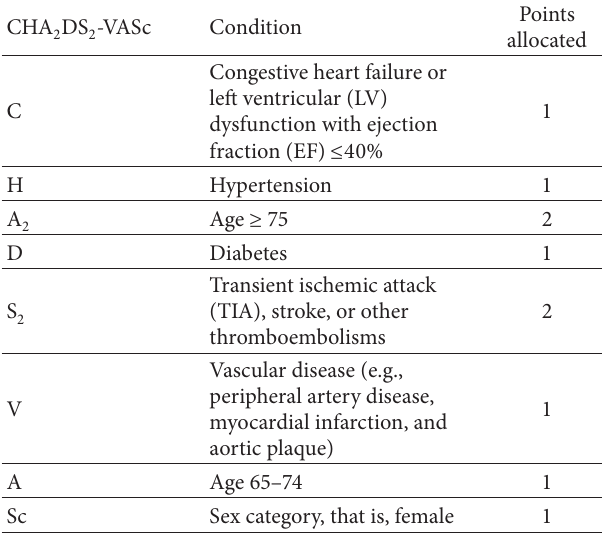
Table 1: Demonstrating the recently described CHA thromboembolic risk score for patients with AF. It has a maximum of nine points where more points equate to higher thromboembolic risk as shown in Table 2.